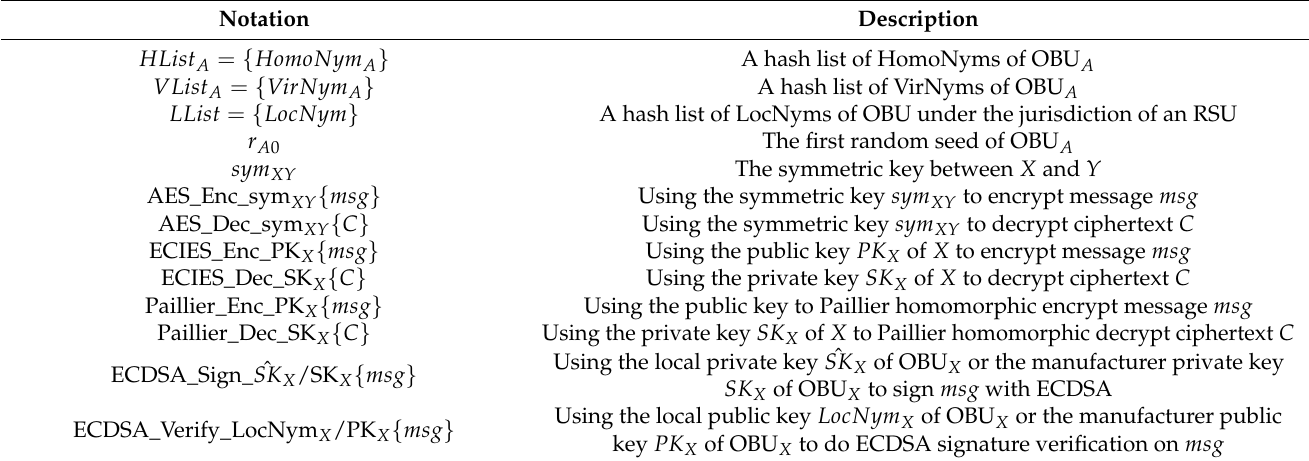
Figure 2. Pseudonym life cycle. Table 1. Scheme notation and its